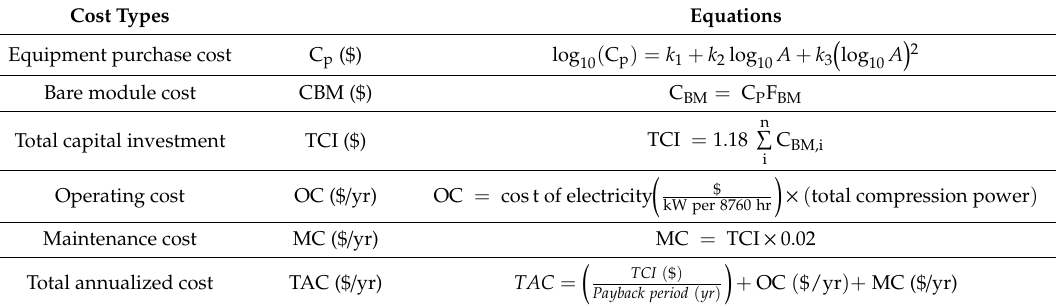
Table 14. Types of cost along with corresponding equations for cost estimation.